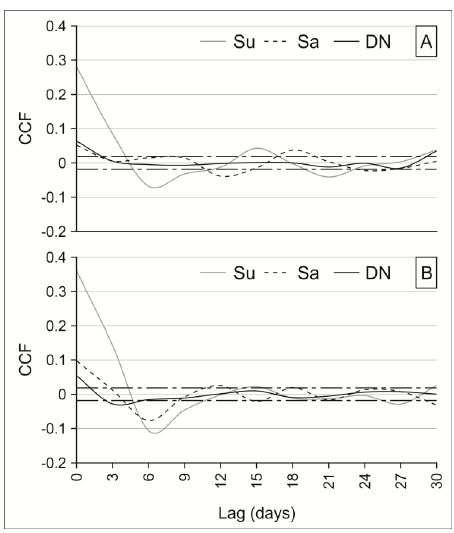
Figure 11. Residual Cross-Correlation Functions: rainfall–piezometric level ( A ); and river level–piezometric level ( B ). The dash-dotted lines indicate the significant thresholds. At Sa well, the maximum CCF value is lower (0.05–0.1), while DN well level presents slight correlations to rainfall and river stage (0.06–0.05).